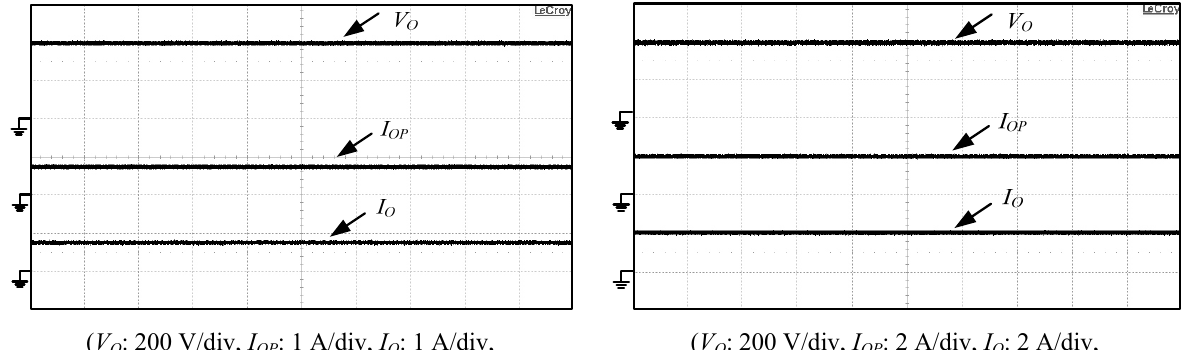
, current I and I waveforms of the proposed PV power O OP O = 320 W; and ( b ) under P L